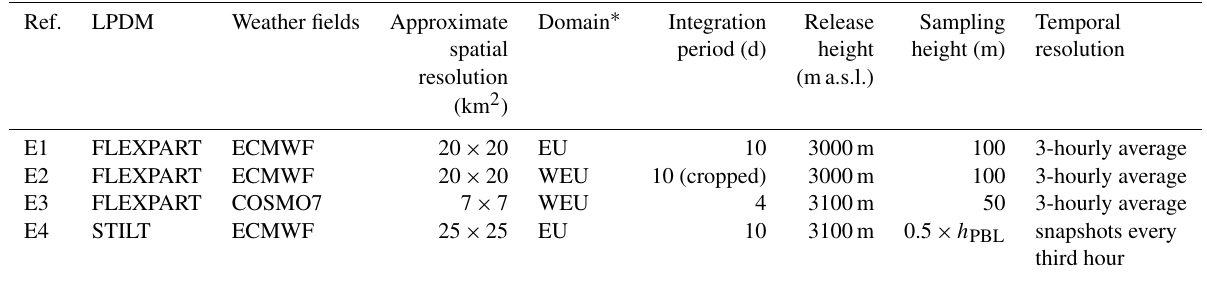
Table A1. Model combinations for transport dynamics analysis. E3 and E4 are the model configurations as used for the CO 2 concentration simulation in the main text. Ref.